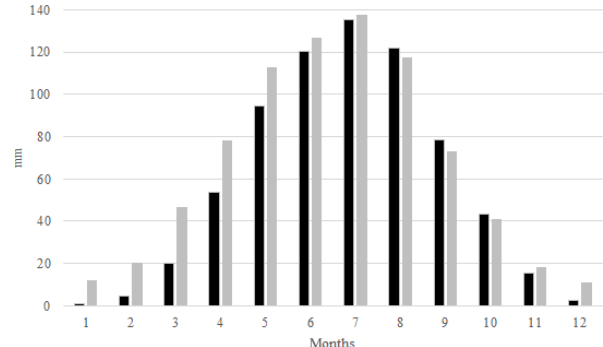
Figure 4. The monthly averages of ET 0 over the CarpatClim re- gion from Penman–Monteith (grey shaded) and Thornthwaite esti- mates (PET_Th) (black shaded) in the Pannonian Basin at eleva- tions lower than 200m for the period 1961–2010.